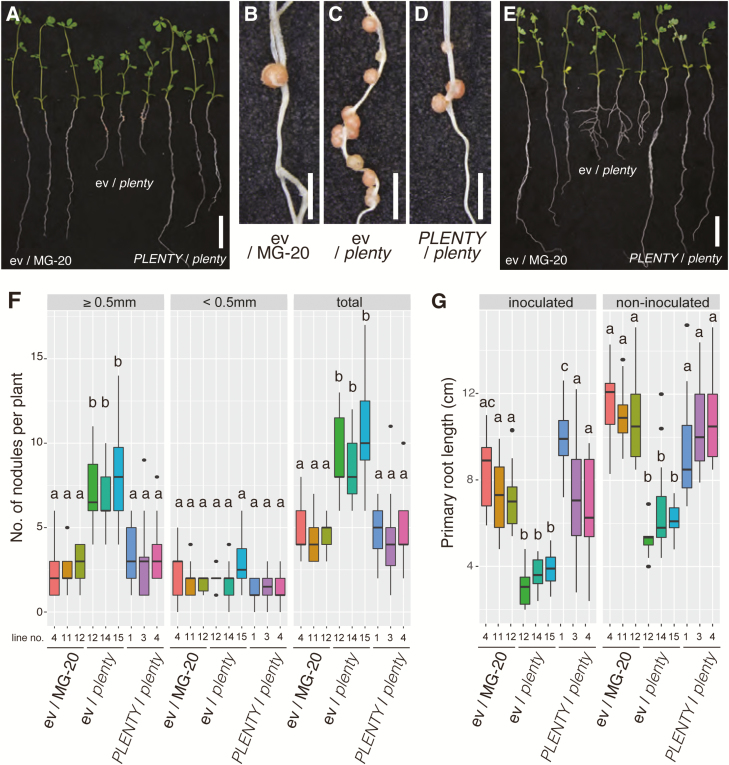
Complementation of plenty. (A) Rhizobium-inoculated MG-20 plants stably transformed with the empty vector pUB-GW-GFP (ev/MG-20), a plenty mutant transformed with the empty vector (ev/plenty), and a plenty mutant transformed with pUB-GW-Full-PLENTY (PLENTY/plenty) at 14 days after inoculation (DAI) with M. loti MAFF303099. Magnified images of the nodulated regions of the ev/MG-20 (B), ev/plenty (C), and PLENTY/plenty (D) plants are shown. (E) Non-inoculated plants of ev/MG-20, ev/plenty, and PLENTY/plenty at 21 days after germination (DAG). (F) Boxplots of the nodule numbers [≥0.5 mm diameter (left), <0.5 mm diameter (middle), and total (right)] of the individual inoculated T3 transgenic lines (n≥10). (G) Boxplots of the primary root length of the inoculated T3 transgenic plants at 14 DAI (left) and the non-inoculated T3 transgenic plant at 21 DAG (right). Scale bars=2 cm in (A, E) and 2 mm in (B–D). Different lower case letters represent statistically significant differences (P<0.05; Tukey’s HSD). Experiments were performed in triplicate (n≥10 in each trial).